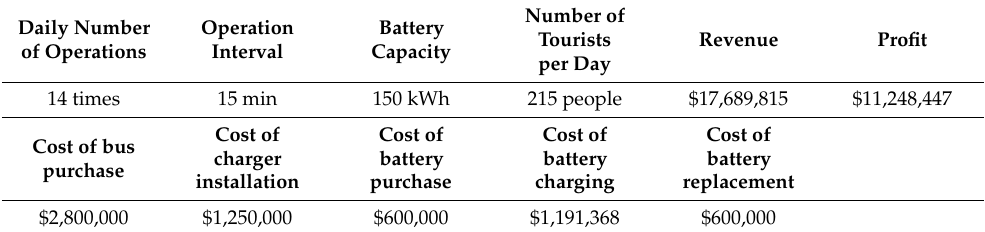
Table 2. The results of the optimal system